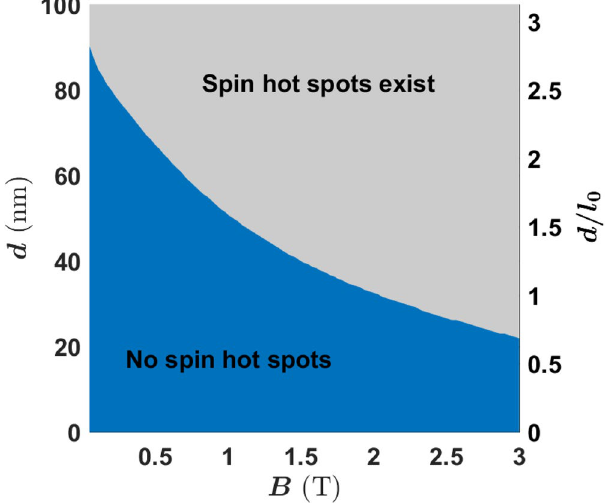
Figure 5. Spin relaxation hot spots in the parameter space of half interdot distance d and magnetic field B , two important adjustable parameters in experiment. The interdot distance is also measured by the confinement  as shown in the right-side scale of y -axis. Other parameters are the same as in length ω = = l m / 32nm 0 0 Fig.